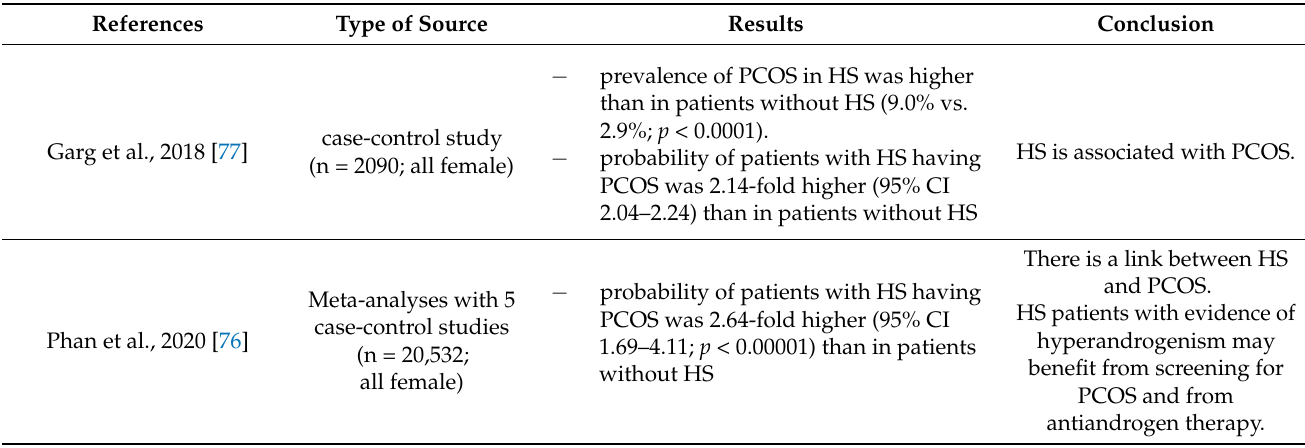
Table 9. Current findings on PCOS and